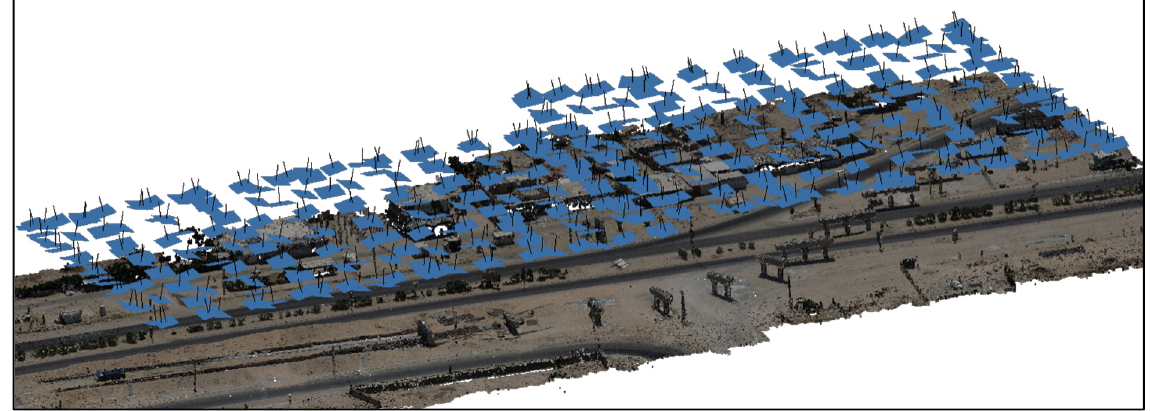
Figure 10. UAV images above the project area of the pier caps for the second test.